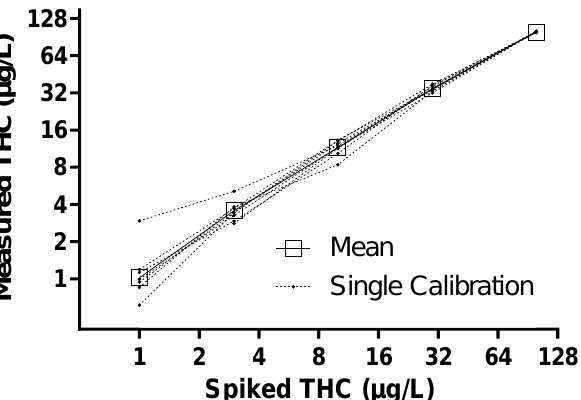
Figure 1. Spiked and calculated THC concentrations after linear regression of measured values of different runs. The THC values were determined by GC-MS in plasma.